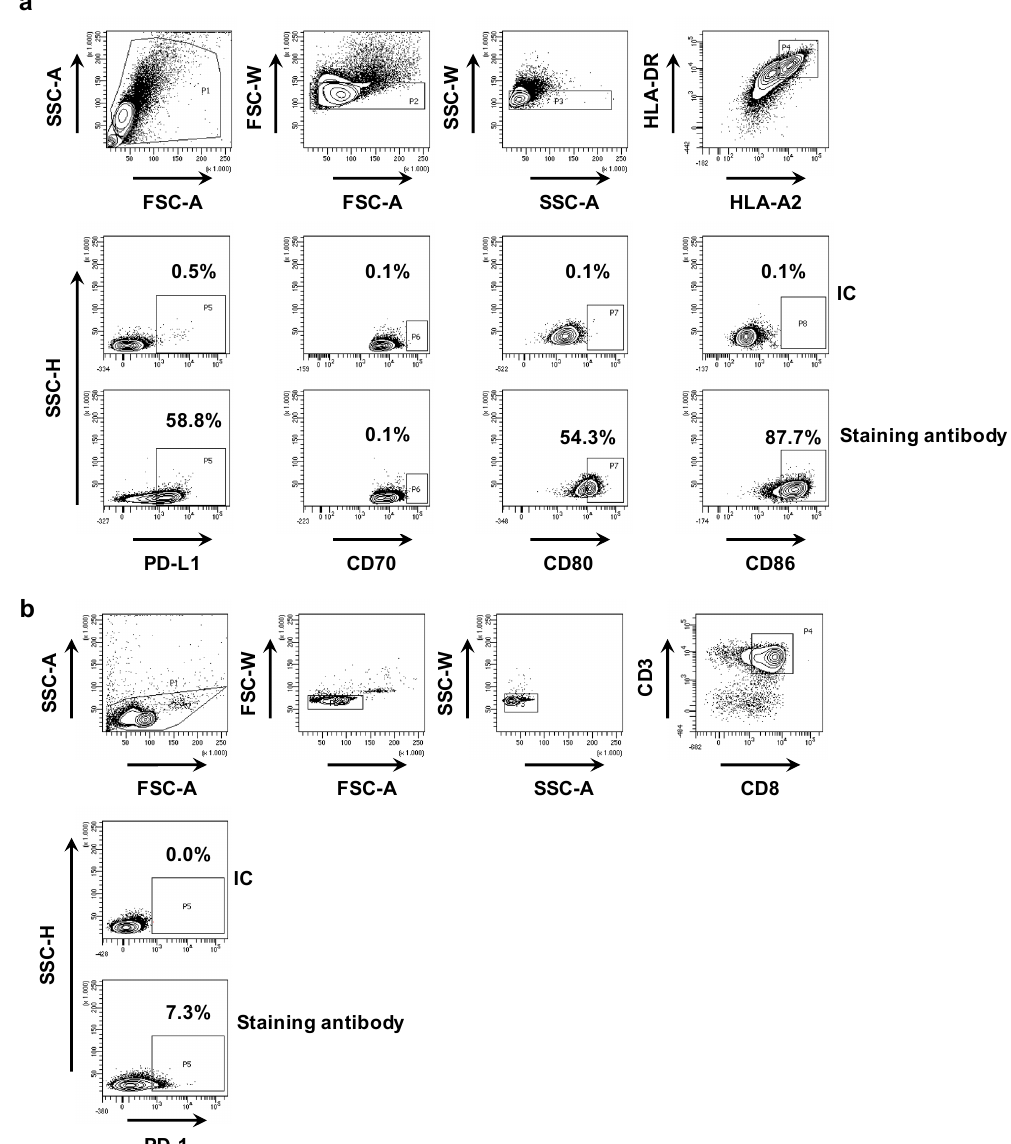
Figure 2. Phenotyping of DC-MEL and CD8 pos T cells. ( a ) Representative flow cytometry graphs showing the gating strategy used to phenotype DC-MEL. Viable cells were selected based on SSC- A/FSC-A characteristics. Subsequently single cells were selected based on FSC-A/FSC-W and SSC- A/SSC-W characteristics. After gating of single cells, PD-L1, CD70, CD80 and CD86 expression was